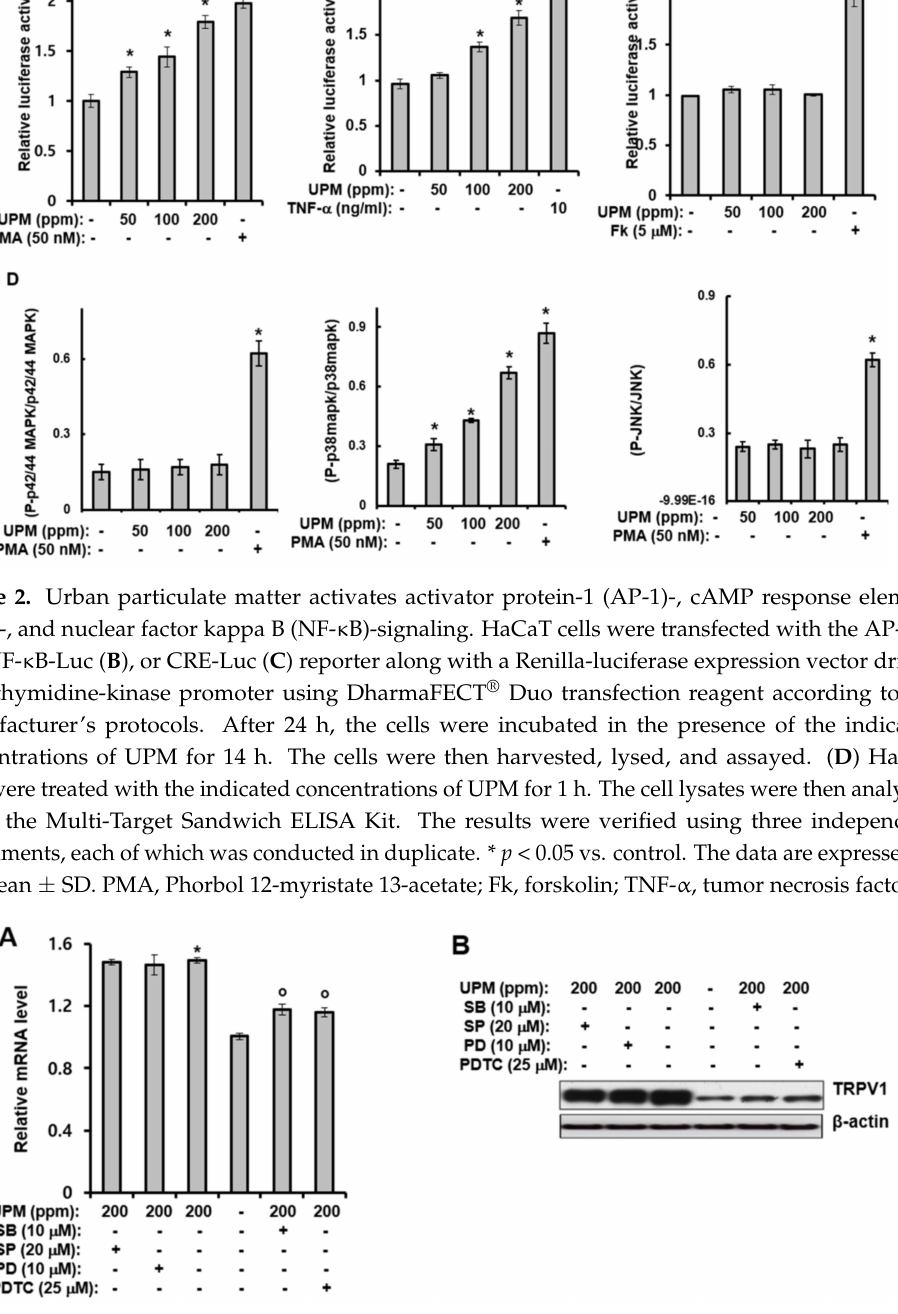
Figure 3. UPM-induced expression of TRPV 1 is mediated through activation of p38 mitogen-activated protein kinase (MAPK) and NF- κ B. HaCaT cells were treated with UPM (200 ppm) and then incubated for two days in the presence of the indicated concentration of MAPK and NF- κ B inhibitors. ( A ) Total RNA was isolated from the cells, and the mRNA levels of the indicated genes were measured using real-time quantitative RT-PCR. The expressed results are relative to the untreated cells after normalization against the GAPDH level. * p <0.05 vs. the untreated control, o p <0.05 vs. the UPM-treated control. The results were confirmed using four independent experiments. Each experiment was conducted in duplicate. The data are expressed as the mean ± SD. ( B ) The cell lysates were subjected to Western blot analysis for TRPV 1. UPM, urban particulate matter; SB, SB203580; SP, SP600125; PD, PD98059; PDTC, ammonium